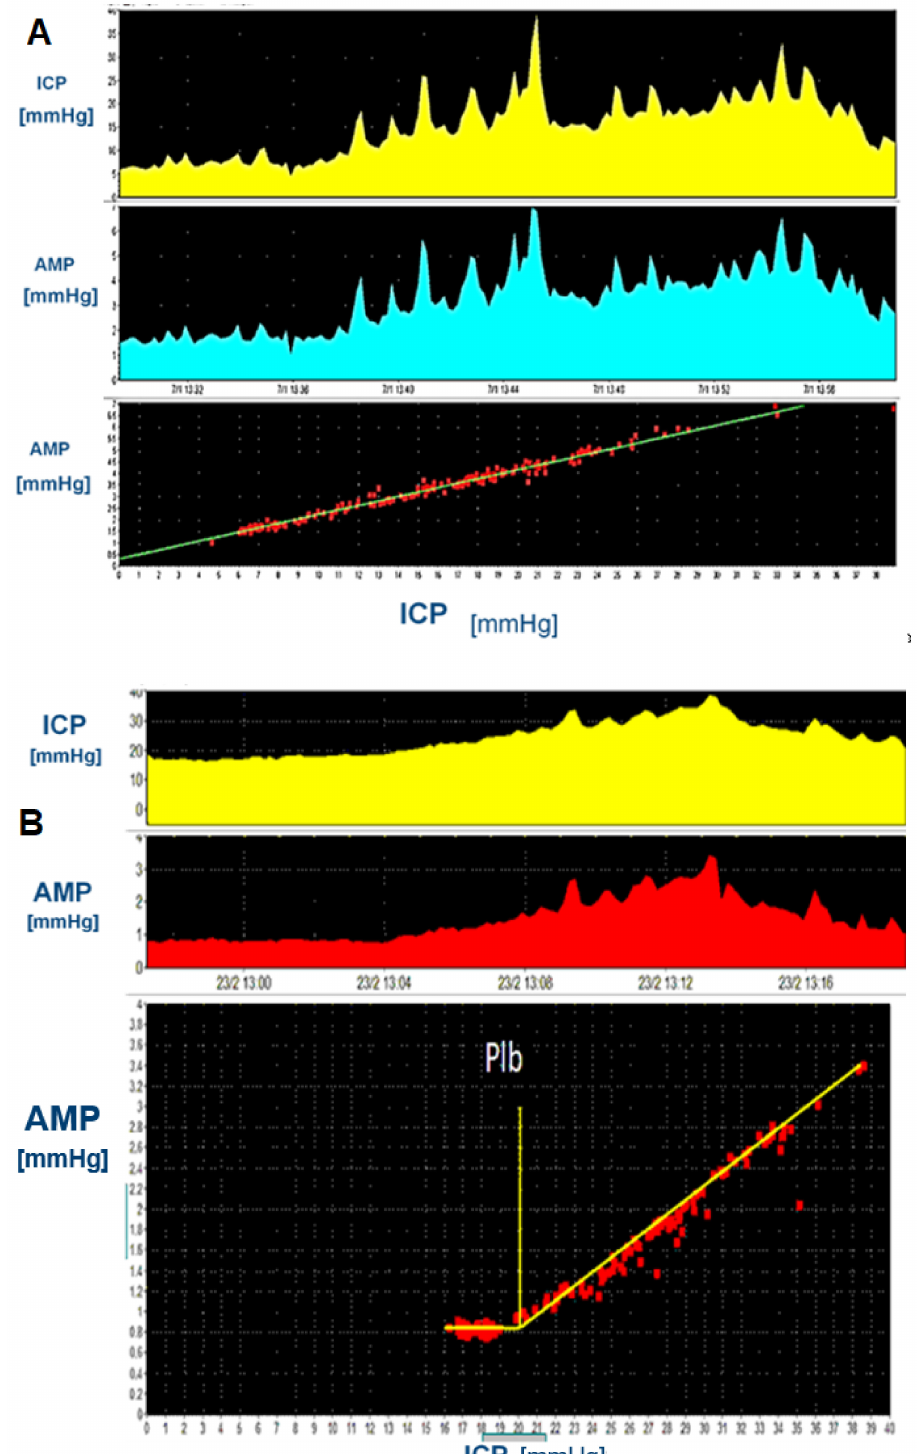
Figure 6. Amplitude-pressure line during infusion tests in Normal Pressure Hydrocephalus ( A ): direct linear relationship between ICP and AMP both at baseline and during infusion. This relation- ship indicates a possible “tighter” equilibrium of cerebral fluids, with volume addition inducing significantly increased ICP and ICP waves. ( B ): Presence of a lower breakpoint in the AMP-P regres- sion (Plb) after which the previously shown linear relationship begins. Physiologically this could be interpreted similarly as a compliant brain with space for pressure–volume